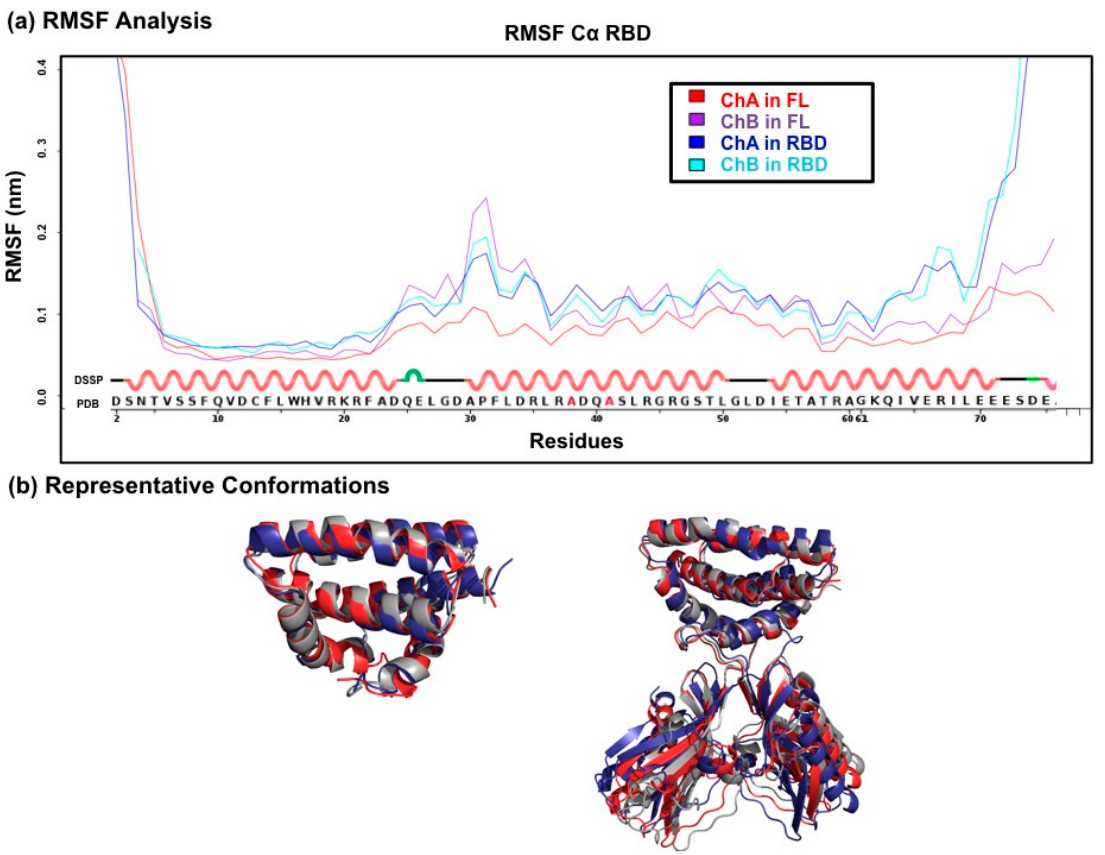
Figure 2. Flexibility of the RBD ( a ) The RMSF curves were computed on the C α of residues 1–73 of each chain of the dimeric RBD (named ChA and ChB). The RMSF of the two chains were computed on the concatenated trajectories of the RBD (blue and cyan curves) or of the FL (red and violet curves). The DSSP secondary structure assignation of the sequence (below) shows red helices linked by loops. ( b ) Shown are the superimposed representative conformations of the three main clusters of conformations obtained by clustering RBD-conf ( left ) and FL-conf ( right ).